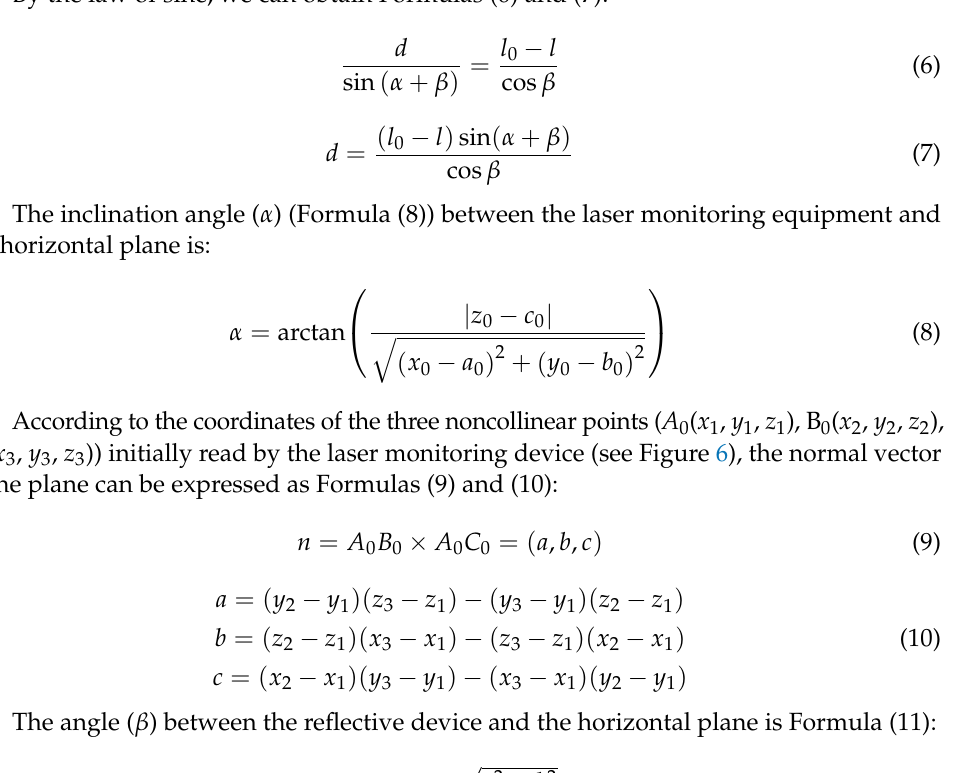
Figure 5. Deflection measurement model of laser monitoring equipment.